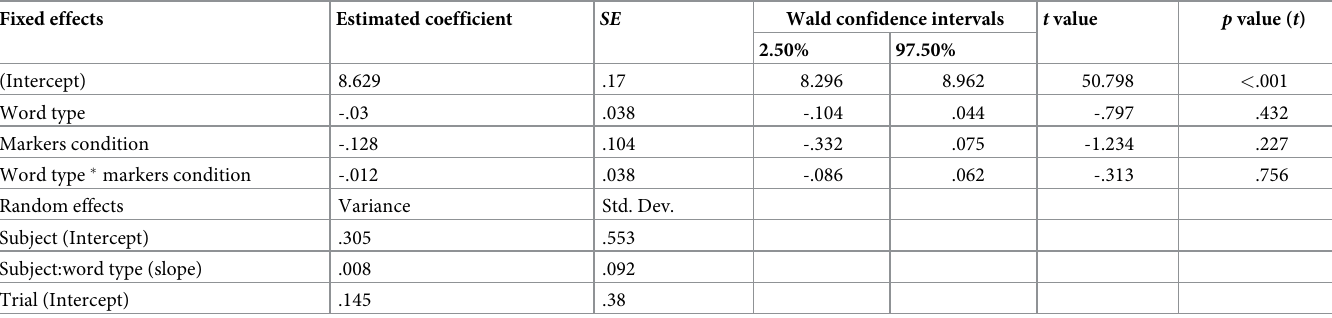
Table 2. Summary of the linear mixed-effects model of (log transformed) looking times on the segmentation trials for participants in experiment